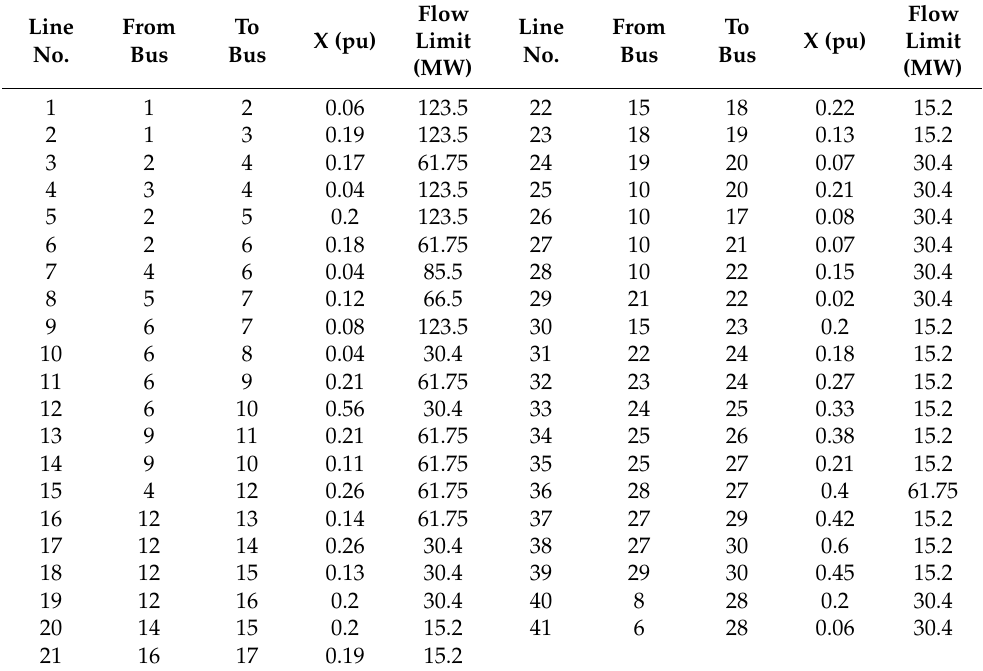
Table A3. Line data of the modified IEEE 30-bus